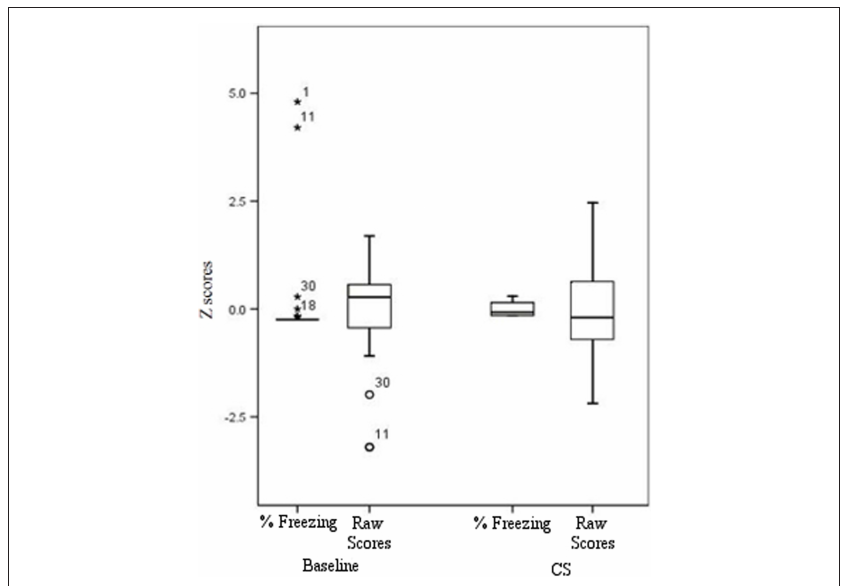
Figure 1 | raw activity and freezing scores under baseline and conditioned stimulus conditions ( n = 44). Raw activity end percent freezing scores (freezing threshold = 18), were automatically generated by the Video-freeze © system. Data were then transformed into z scores in older to allow for comparisons between the two scales.